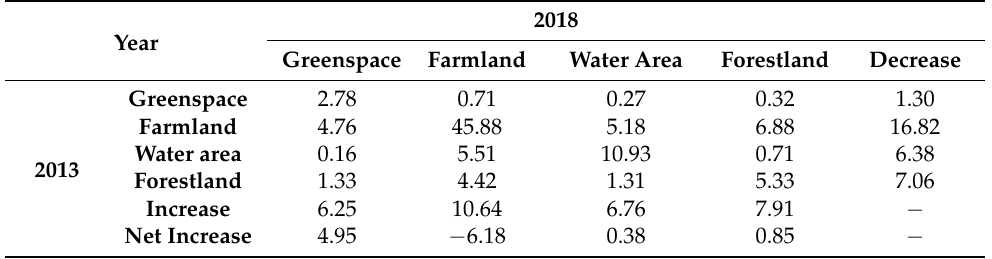
Table 5. GI transformation area (km 2 ) matrix from 2013 to 2018.